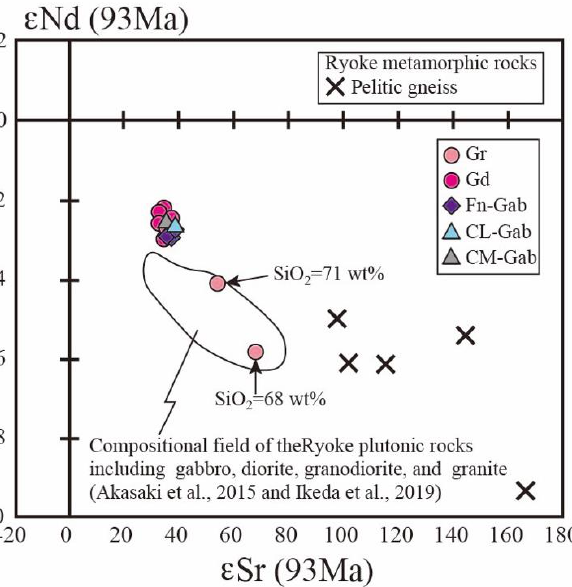
Figure 8. Epsilon Sr and Nd isotopic initial values corrected with 93Ma of the SNPC. Gr, granite [15]; Gd, granodiorite [16].